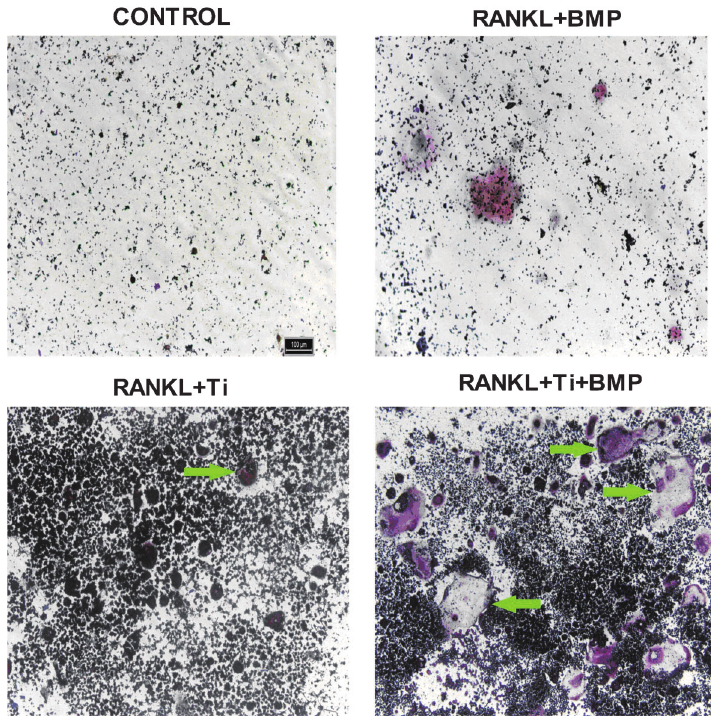
Figure 3. TRAP staining of RAW 264.7 cells- derived osteoclasts differentiated with 30 ng/mL RANKL, 50 ng/mL BMP-2, or 150 m g/mL tita- nium (Ti) particles for 5 days. TRAP-positive multinucleated cells (arrows) were observed in the RANKL++Ti and RANKL++Ti++BMP. No TRAP-positive multinucleated cells were observed in control and